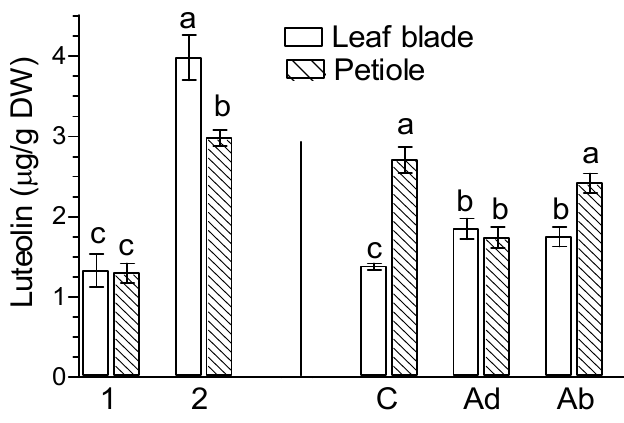
Figure 3. Effect of methyl jasmonate (JA-Me) on the content of flavones in the leaf blade and petiole of G. biloba . Mean results ± SD followed by the same letter calculated for the natural senescence process and JA-Me treatment separately were not significantly different ( p < 0.05) according to Tukey’s test. Description of samples: 1, initial time (9 September); 2, naturally senesced yellow leaves (20 October); C, control (lanolin); Ad, JA-Me applied to the adaxial side of the leaf blade; Ab, JA-Me applied to the abaxial side of the leaf blade. C, Ad, and Ab samples were collected for analysis on 30 September.